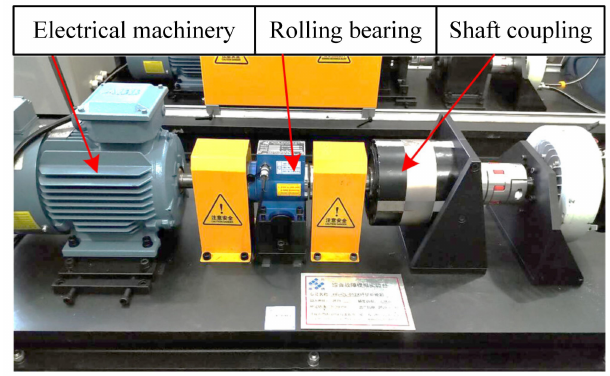
Figure 6. SpectraQuest’s mechanical failure simulator.